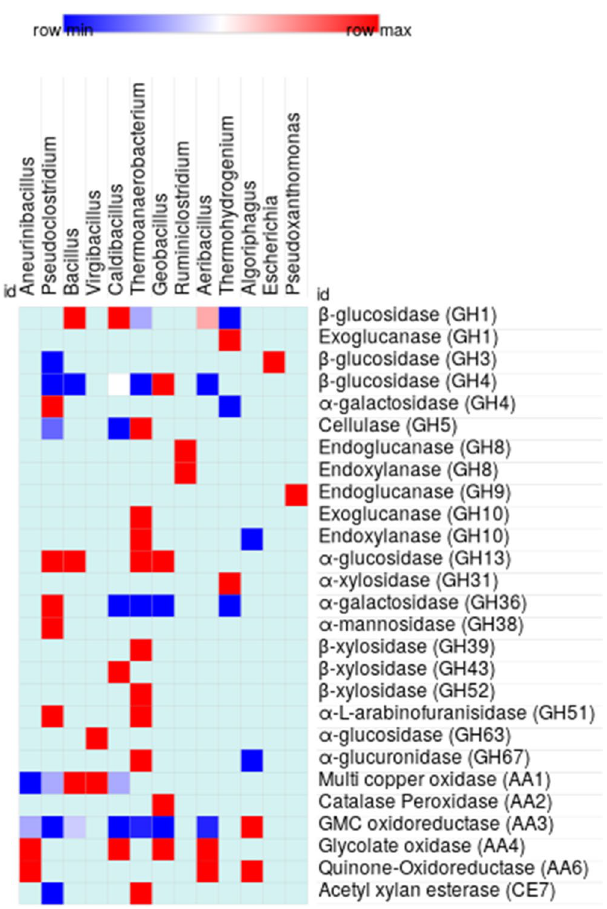
Figure 8. Heat map showing the distribution of glycoside hydrolase (GH) and auxillary activities (AA) families in bacterial genera in the RSV consortium. Only the GH families targeting cellulose, hemicelluloses and lignin are taken into